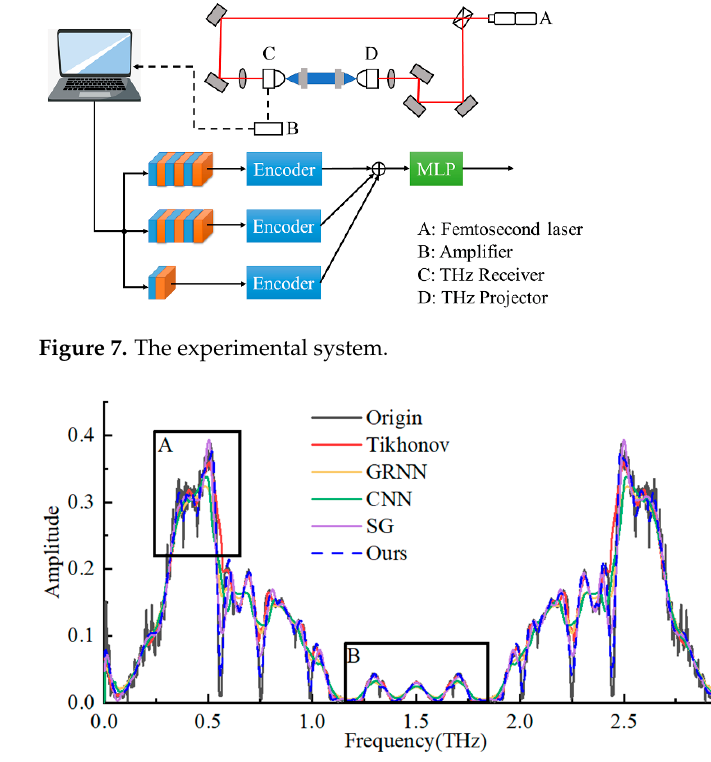
Figure 10. The restored effect of region B. ( a – e ) Comparison of real THz spectra with Tikhonov, GRNN, CNN, SG, and the proposed method, respectively. The error bars are calculated from the standard deviation. ( f ) The denoising effect without error bars. The restored results by all denoising methods are illustrated in Figures 8–10. Figure 9a–e show the magnified view of region A, and Figure 9f shows the denoising effect. Similarly, Figure 10 shows the he magnified view of region B. In the measured spectrum experiment, the signal loss is the universal problem, where the proposed algorithm has